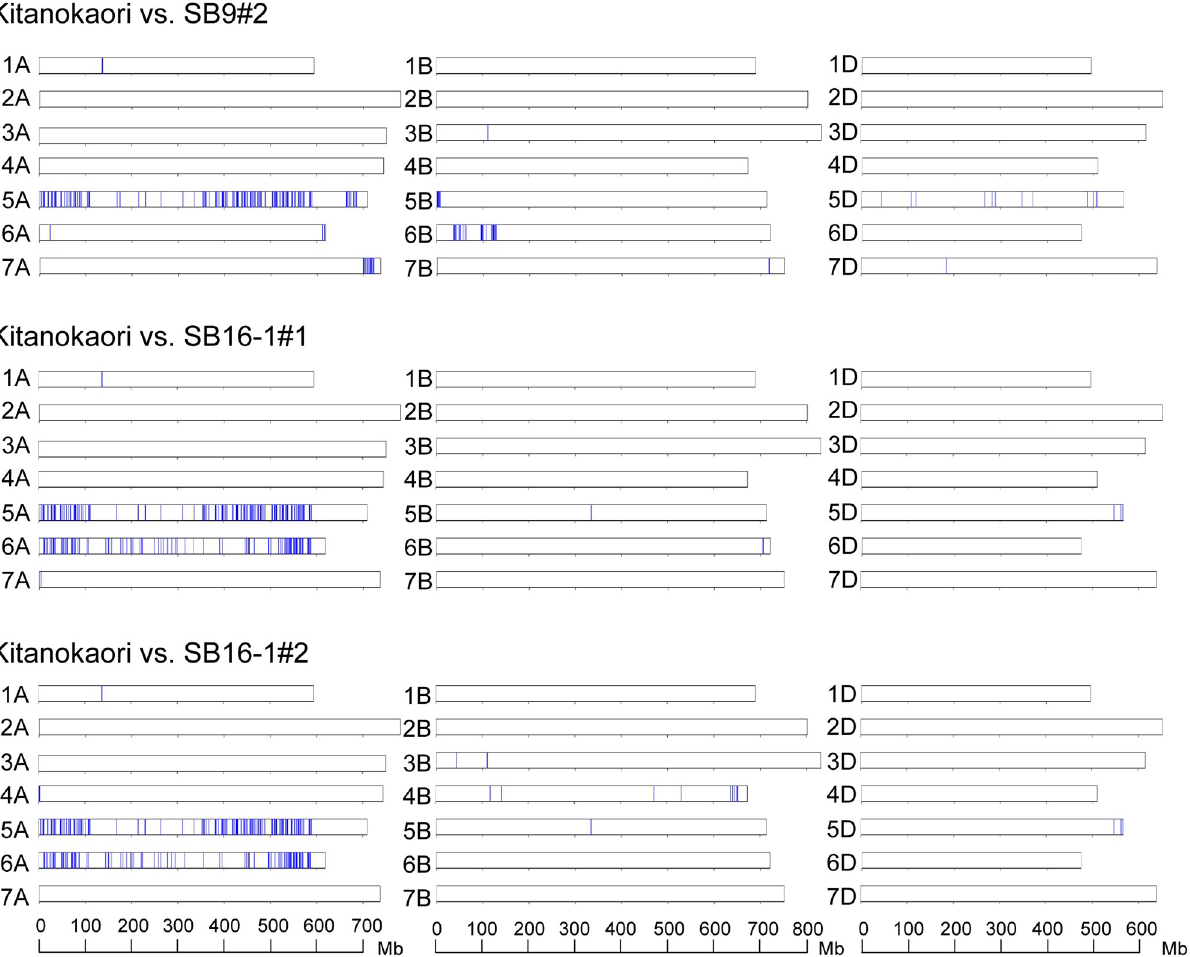
Fig 6. Genome-wide graphical genotypes of the three selected early heading lines of Kitanokaori. Vertical bars (blue) indicate the SNP sites detected between the three selected lines and their backcrossed parental cultivar Kitanokaori on each of the 21 wheat chromosomes.